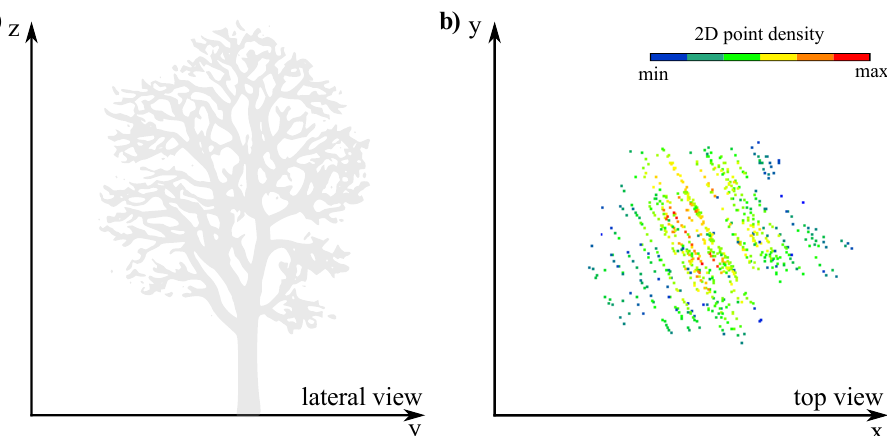
Figure 3. ( a ) lateral view of the point cloud representing an individual tree; ( b ) areal point density computed for the same tree after that all the point are projected on the ground (plane z = 0)